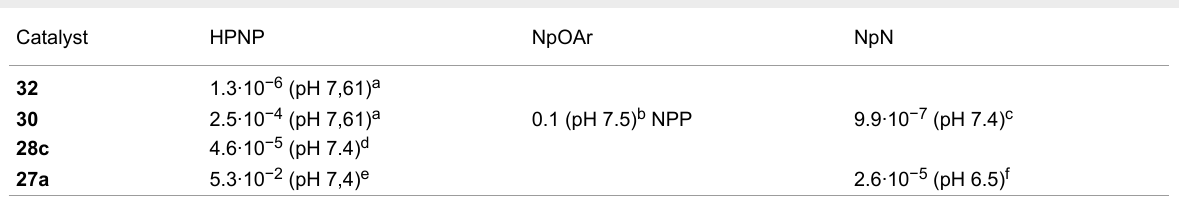
Table 3: Pseudo first-order rate constants (s − 1 ) of phosphoester hydrolysis/transesterification in the presence of bimetallic and monometallic com- plexes (1 mmol L − 1 ) under neutral conditions.